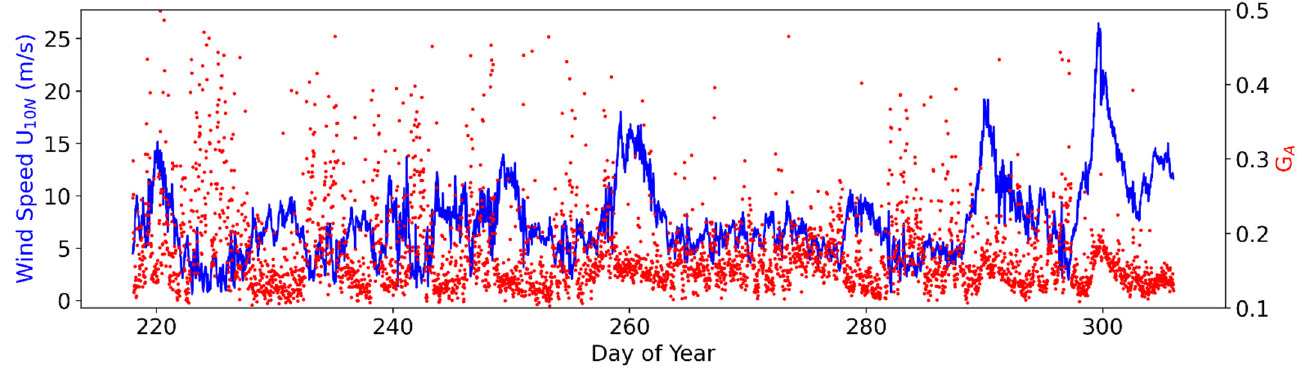
Figure 3. U (cid:2869)(cid:2868)(cid:2898) (blue) and 𝐺 (cid:3002) (red) during the experiment. Figure 3. U 10N (blue) and G A (red) during the experiment.